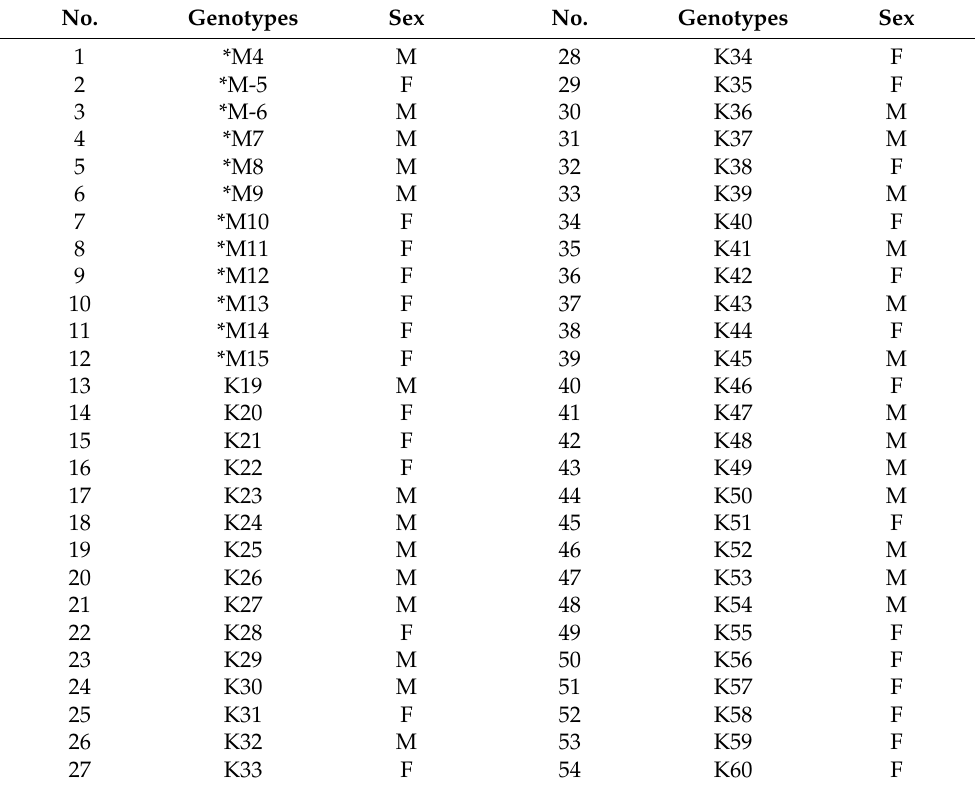
Table 1. The studied genotypes of Pistacia